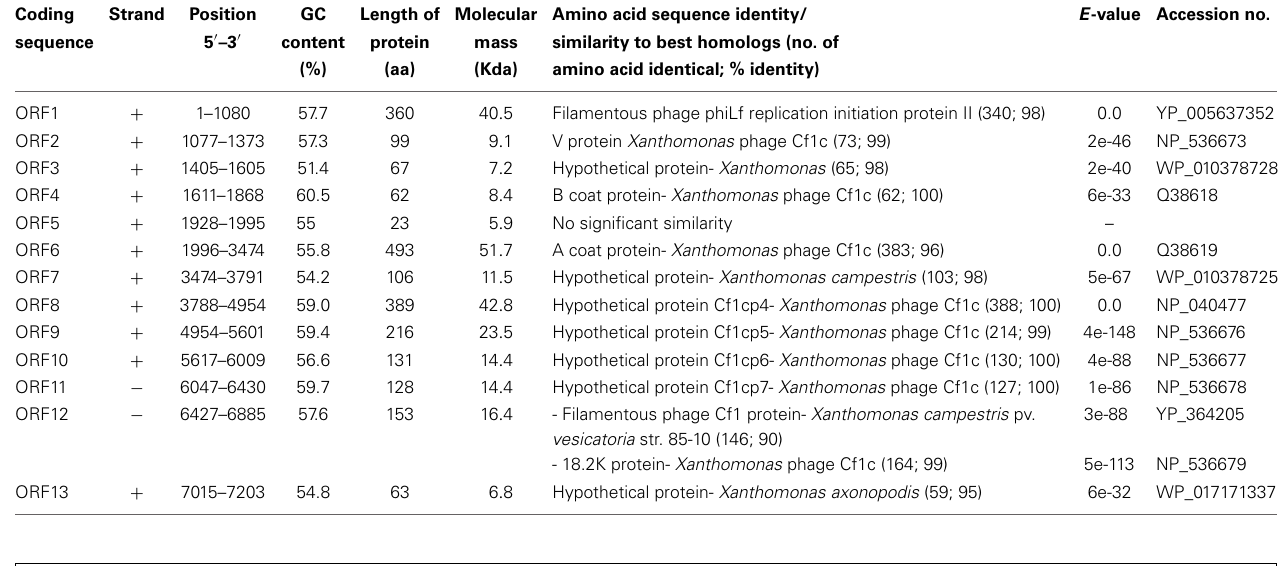
Table 2 | Predicted ORFs found in the XacF1 genome.